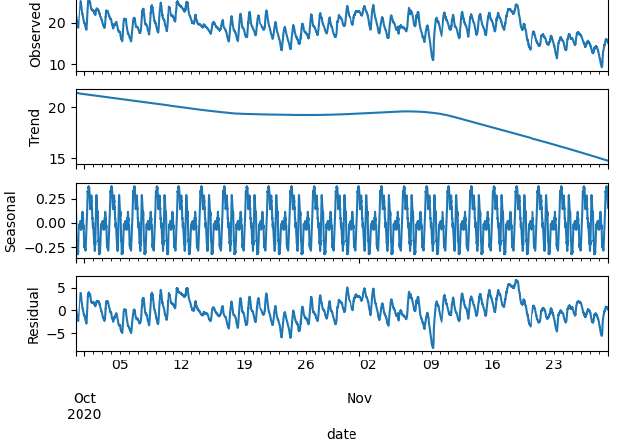
Table 6. Correlation coefficient of the residual component environmental variables of the rabbit house.